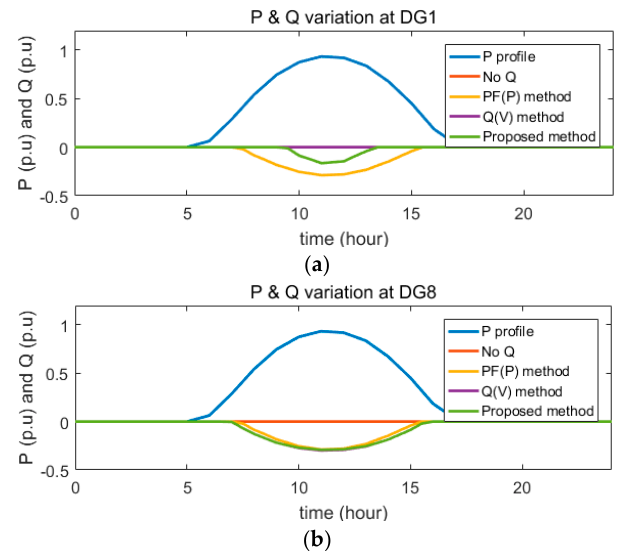
Figure 11. Active power output and reactive power output by the different methods at ( a ) DG1 and Figure 12. Active power output and reactive power output by the di ff erent methods at ( a ) DG1 and ( b ) DG8 and reactive power output by reactive power control method. ( b ) DG8 and reactive power output by reactive power control